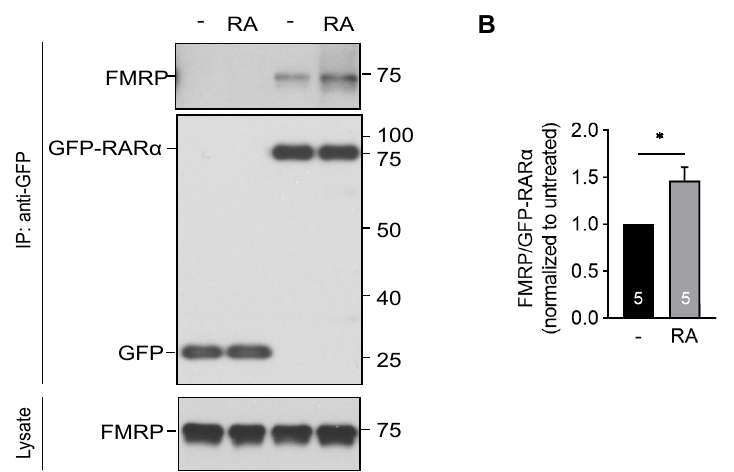
Figure 4. Retinoic acid enhances the interaction between FMRP and RAR α . ( A ) Immunoprecipi- tation with anti-GFP antibodies of FMRP with GFP-RAR α in RA treated (1 µ M for 1 h) HEK cells. ( B ) Quantification of the amount of FMRP immunoprecipitated by GFP-RAR α after treatment with RA (Student’s t -test, n = 3; * p < 0.05). The graph represents average values ±